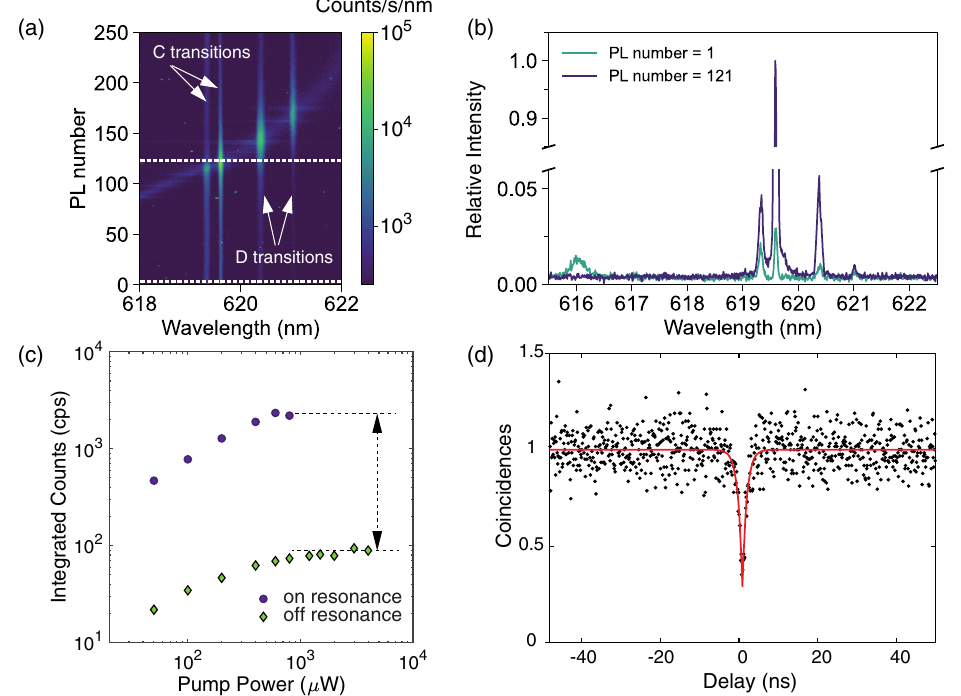
FIG. 2. Intensity enhancement of SnV − centers. (a) Consecutive PL spectra acquired while gas tuning the cavity through resonance with the ZPLs of the two SnV − centers. Two horizontal white dashed lines indicate locations of line cuts examined in (b). (b) Two line cuts acquired when the cavity mode is 3.6 nm blue detuned from the C transition (teal) and when the cavity mode is resonant with the C transition of interest at 619.6 nm (purple). (c) Saturation of the SnV − center when cavity mode is 2.72 nm blue detuned from the resonance (green diamonds) and when the cavity mode is resonant with the C transition at 619.6 nm (purple circles). In the resonant case the maximum achieved intensity of the C transition of the SnV − center is about 30 times greater than when the cavity is off resonance. (d) Second-order autocorrelation measurement of SnV − center when the cavity mode is resonant with the C transition. A fit (red) to the data (black) reveals a g ð 2 Þ ð 0 Þ ¼ 0 . 29 (cid:2) 0 . 08